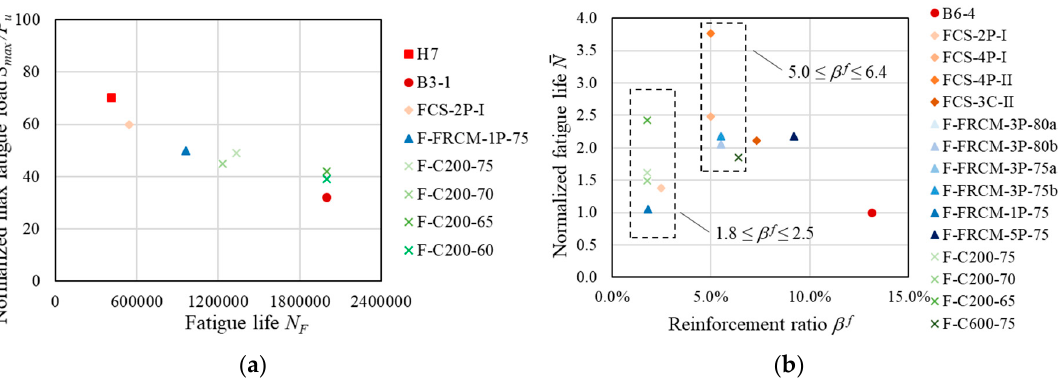
Figure 2. State of the art analysis: ( a ) relationship between normalized maximum applied fatigue load and fatigue life; ( b ) relation between normalized fatigue life and reinforcement ratio.